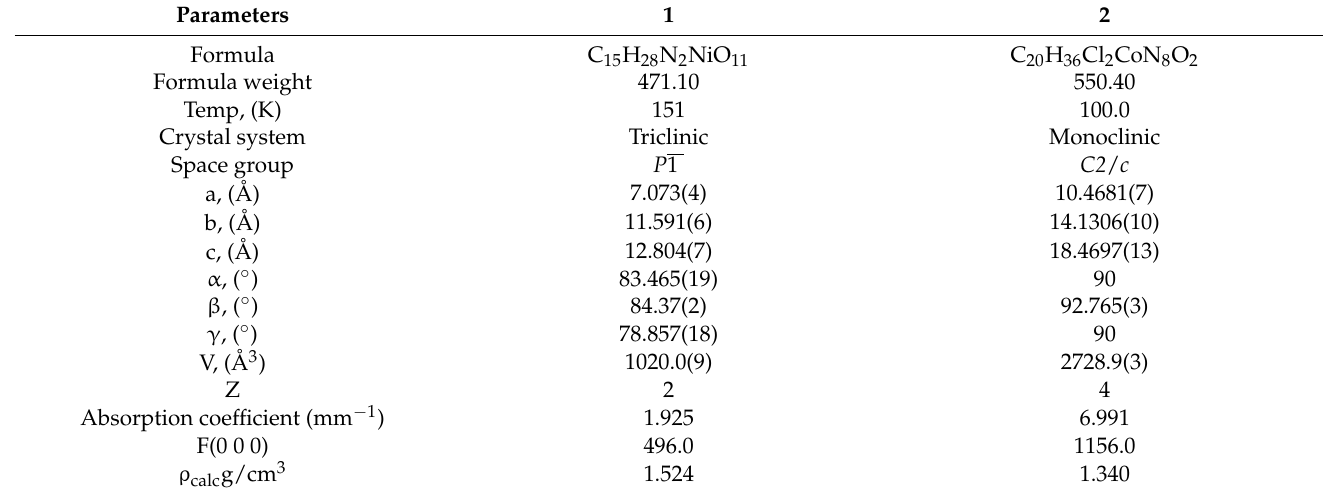
Table 1. Crystallographic data and structure refinement details for the compounds 1 and 2 .